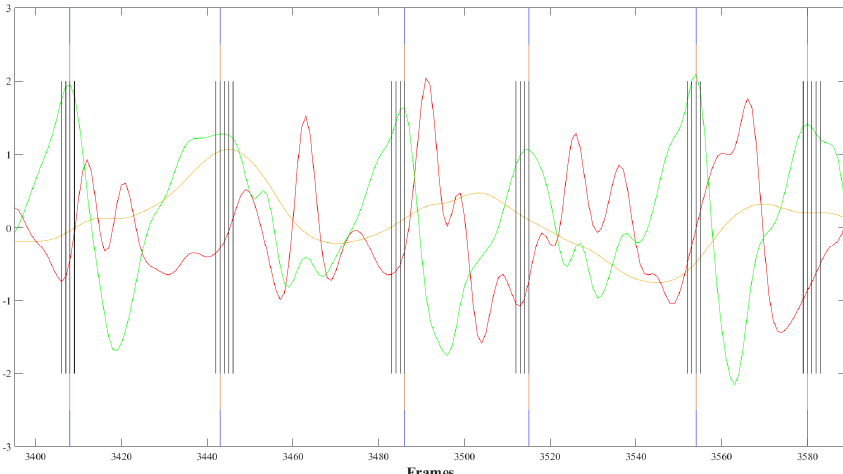
Figure 2. “Banded” groupings of foot strike predictions surrounding AP signal peak occurred in all participants. Anterior-posterior (green), vertical (red), and medio-lateral (yellow) accelerations for 6MWT were graphed over time. Black vertical lines indicate model predictions of “FS present” prior to correction. Blue lines indicate ground truth labels for foot strikes. Orange lines indicate adjusted predictions corresponding with a peak in AP acceleration with banded periods. To correct for missed steps, a method similar to Capela et al. [4] was employed. A locking period specific to each participant’s trial was defined from a 5-s sample of the filtered vertical acceleration signal from the beginning of the 6MWT trial. The time be- tween positive zero-crossings for the vertical acceleration signal in the sample was used